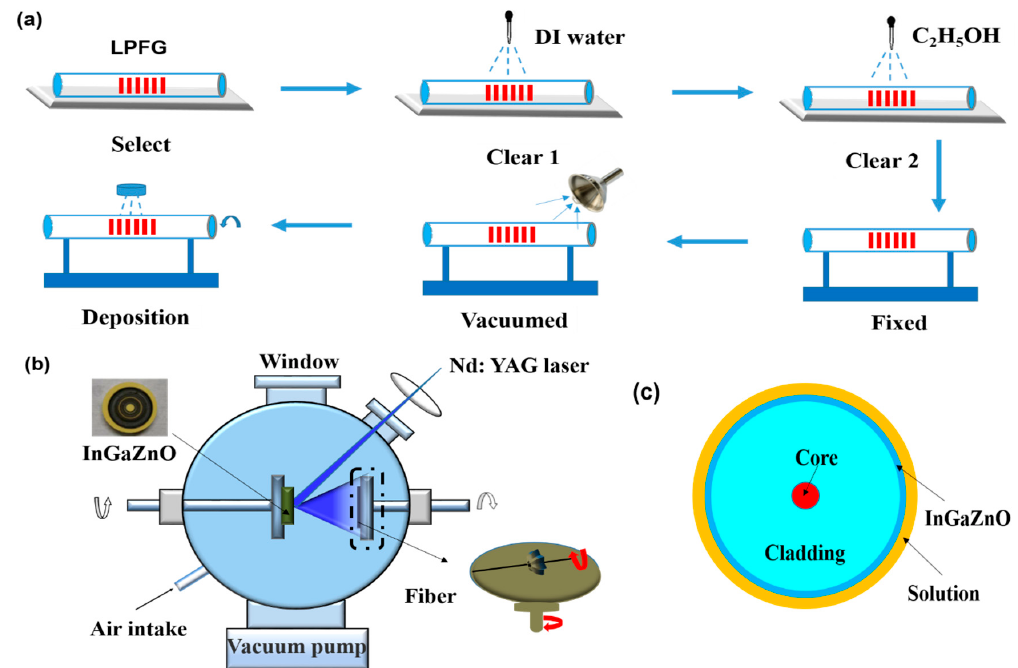
Figure 3. ( a ) Grating cleaning and coating process ( b ) Vacuum cavity structure ( c ) Four layer membrane structure of LPFG.